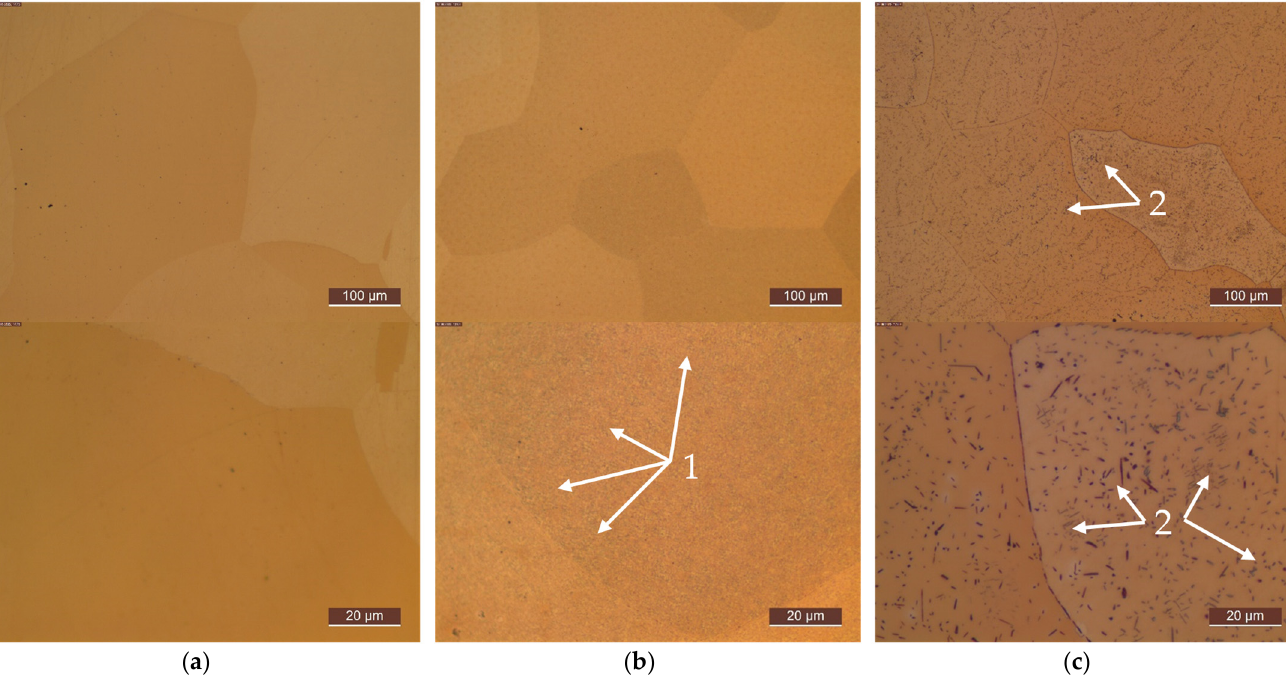
Figure A7. Microstructure evolution of CuSc0.3 during DSC measurements in the optical micro- scope: specimen without cold rolling; ( a ) initial state; and after DSC measurement; ( b ) condition 1; ( c ) condition 2; showing homogenously distributed fine precipitates (1) and coarsened scandium precipitates